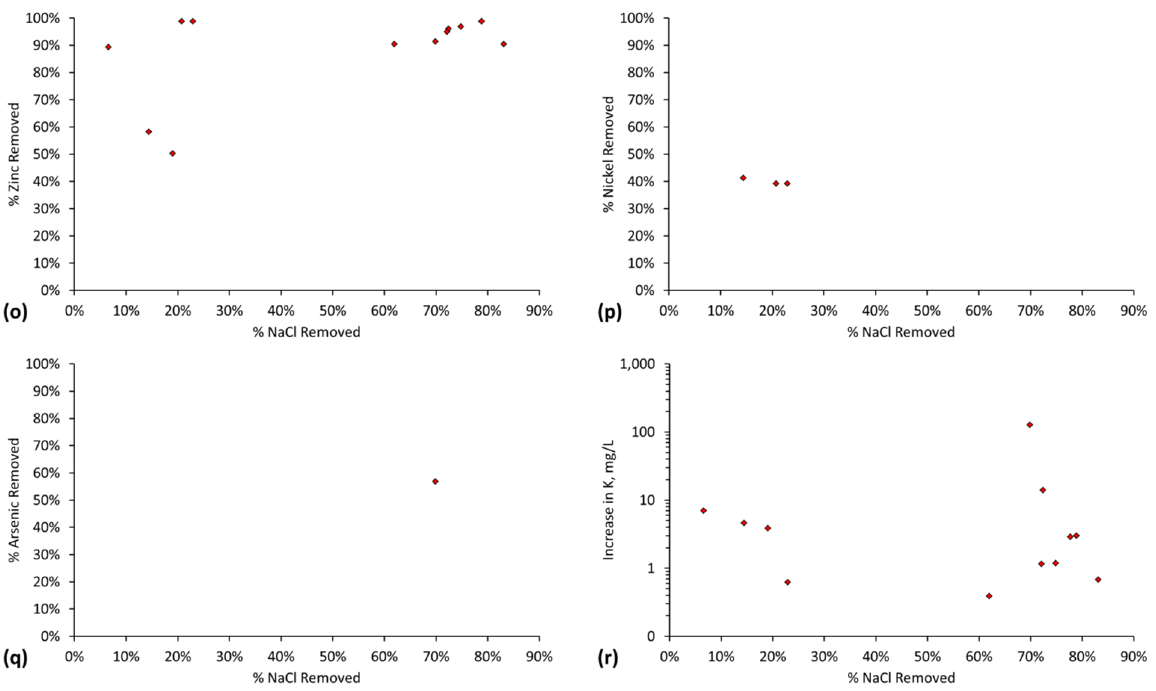
Figure C18. Observed anion and cation removal associated with NaCl